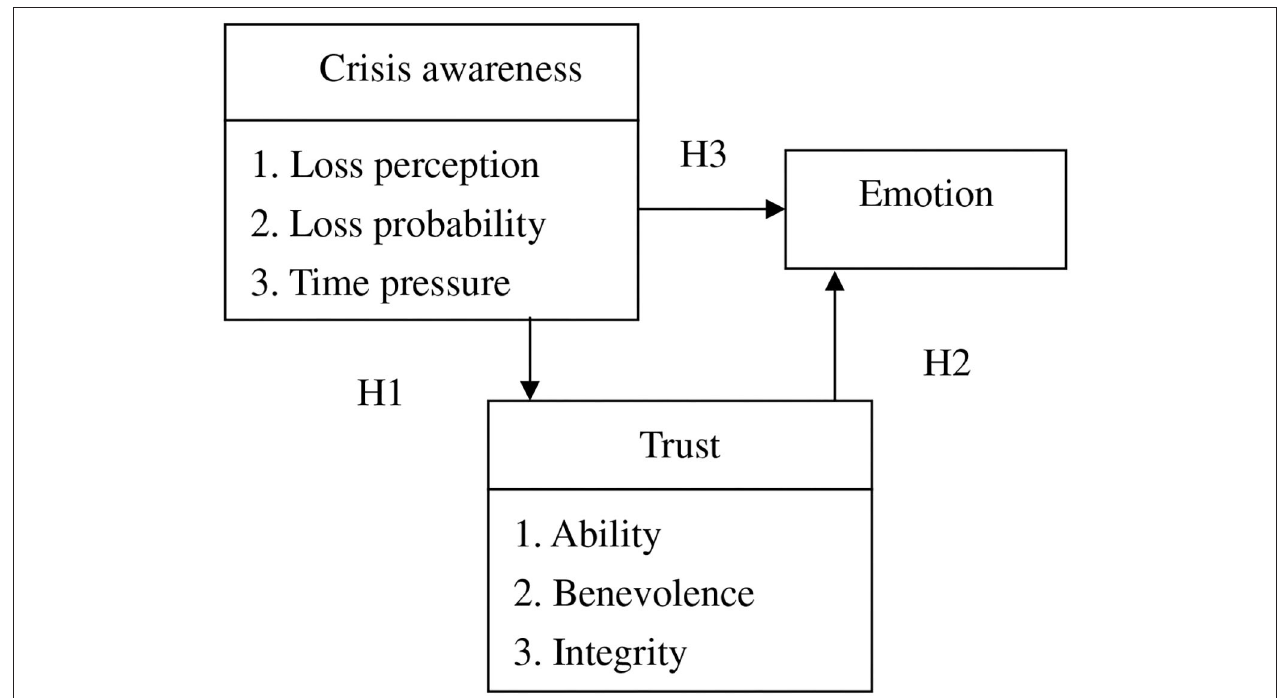
FIGURE 1 | Conceptual